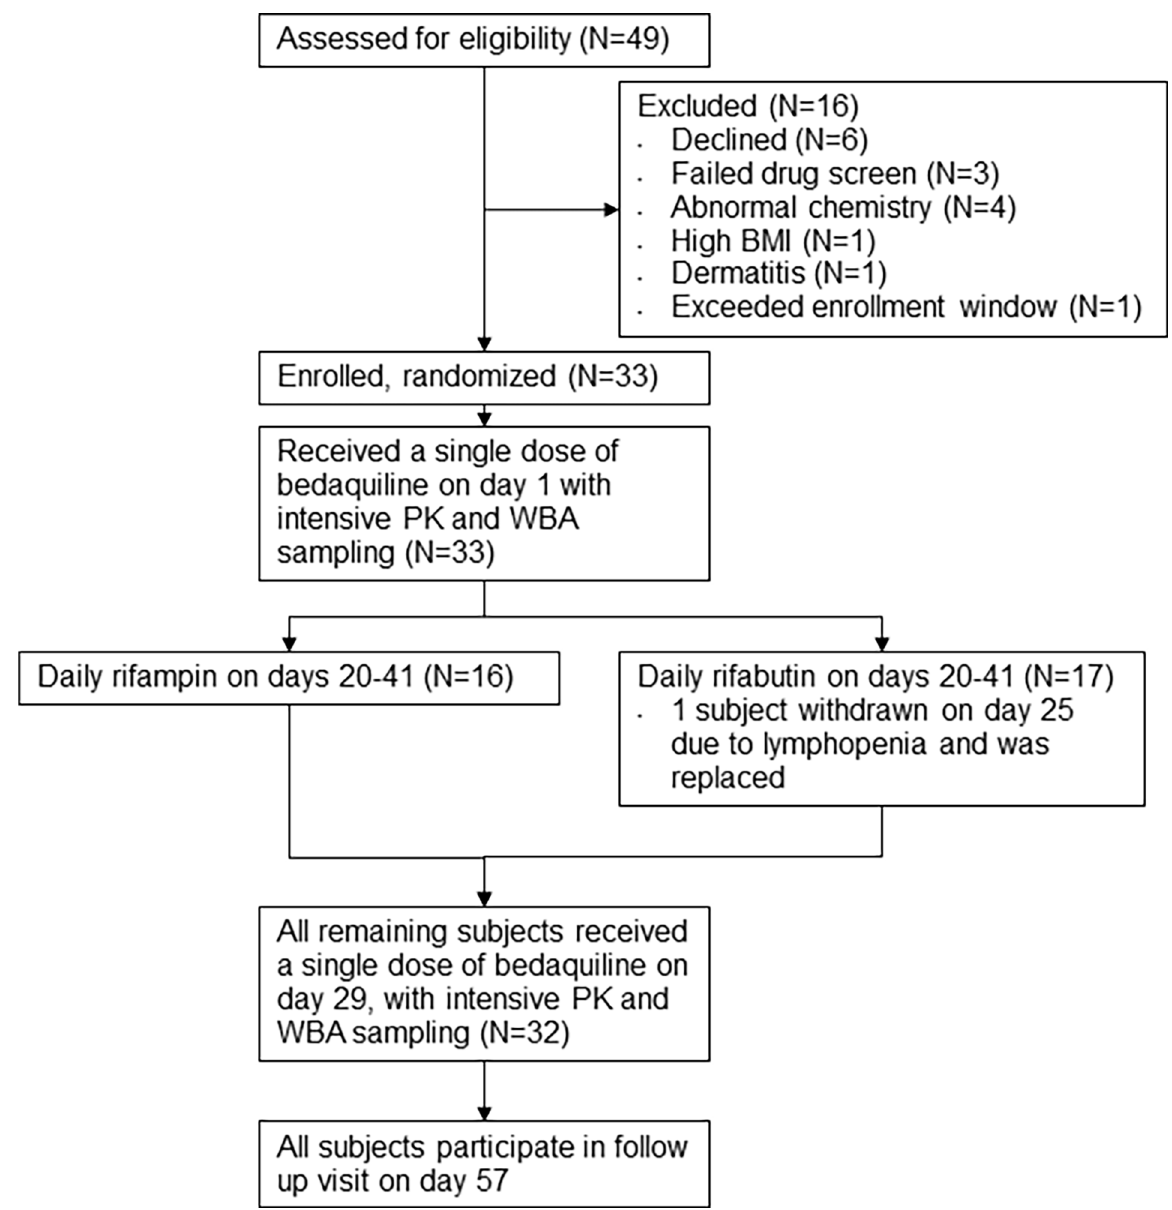
Fig 1. Study flow